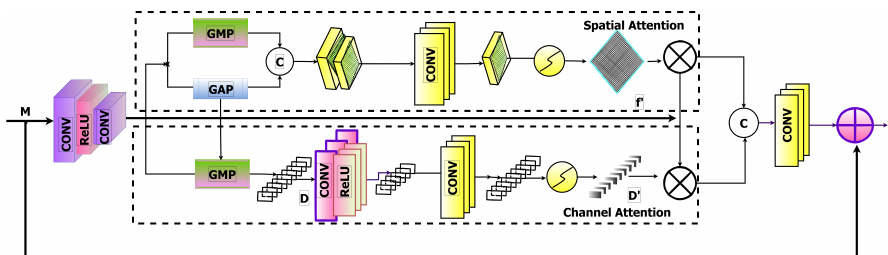
Figure 5. Dual-Attention Module including spatial and channel